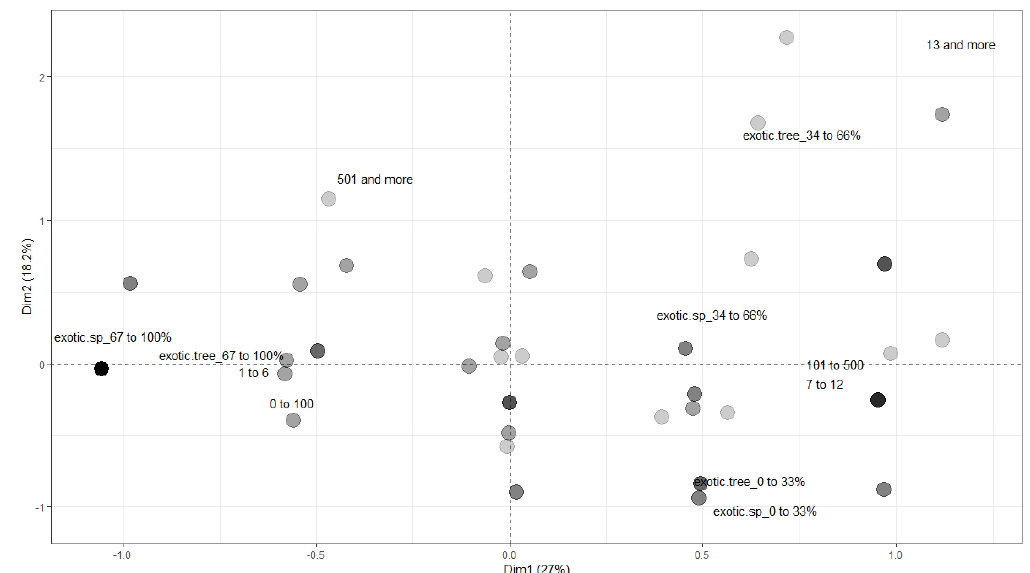
Figure 4. Multiple Correspondence Analysis (MCA): each point corresponds to a farmer interviewed and its position relates to tree planting choices of each farmer interviewed. Darker points correspond to overlapping observations.